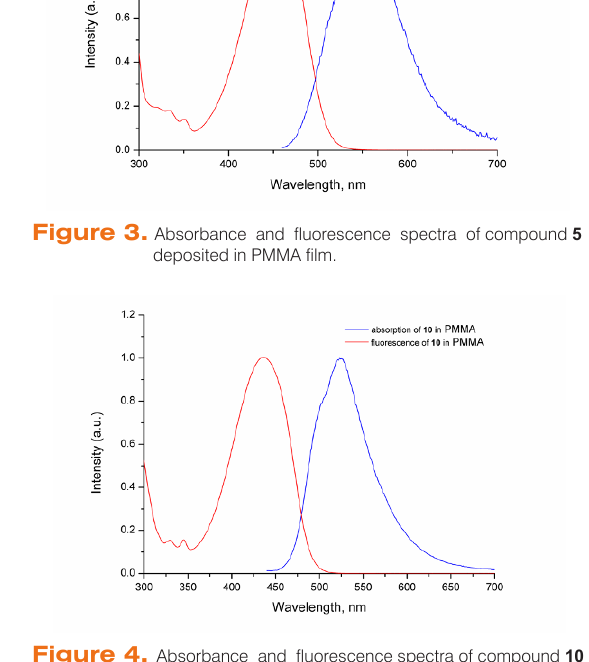
Figure 4. Absorbance and fluorescence spectra of compound 10 deposited in PMMA